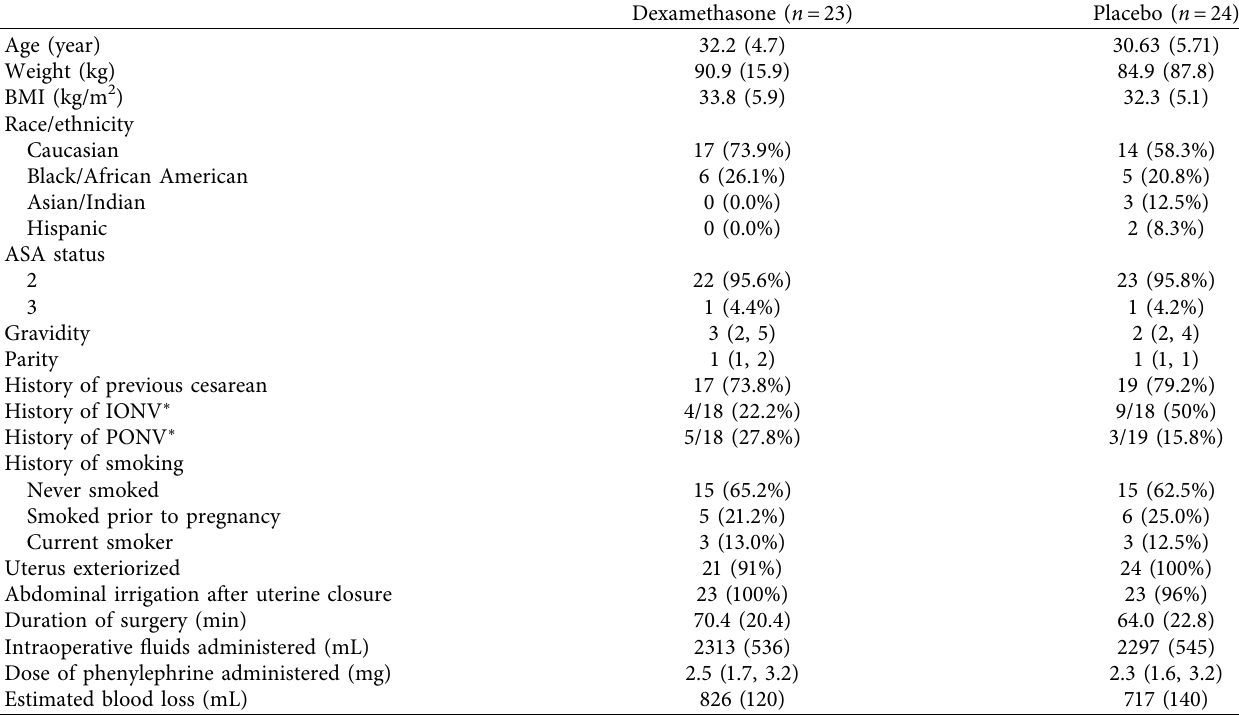
Table 1: Subject characteristics.